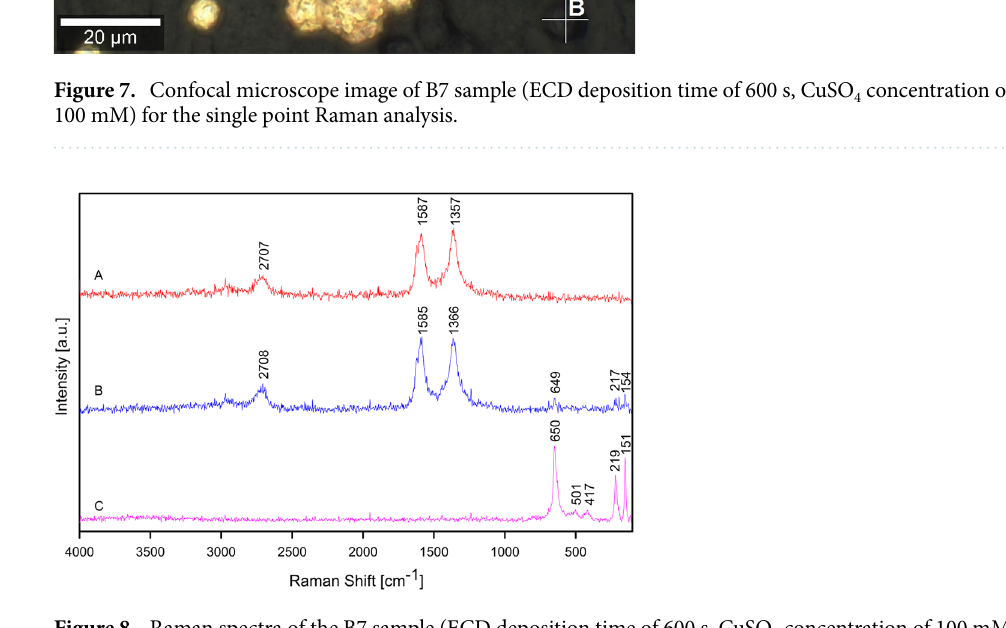
Figure 8. Raman spectra of the B7 sample (ECD deposition time of 600 s, CuSO 4 concentration of 100 mM) in points